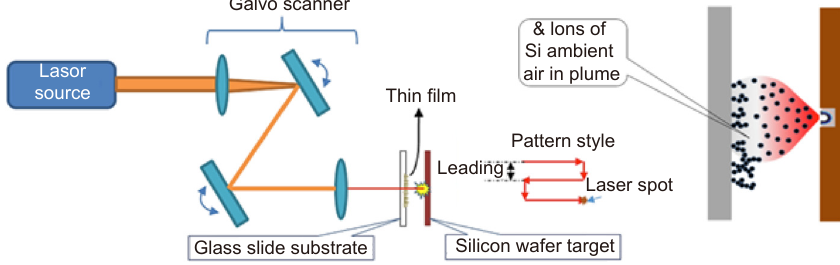
Fig. 1 | Schematic of fabrication set-up. Figure reproduced with permission from ref. 6 ,